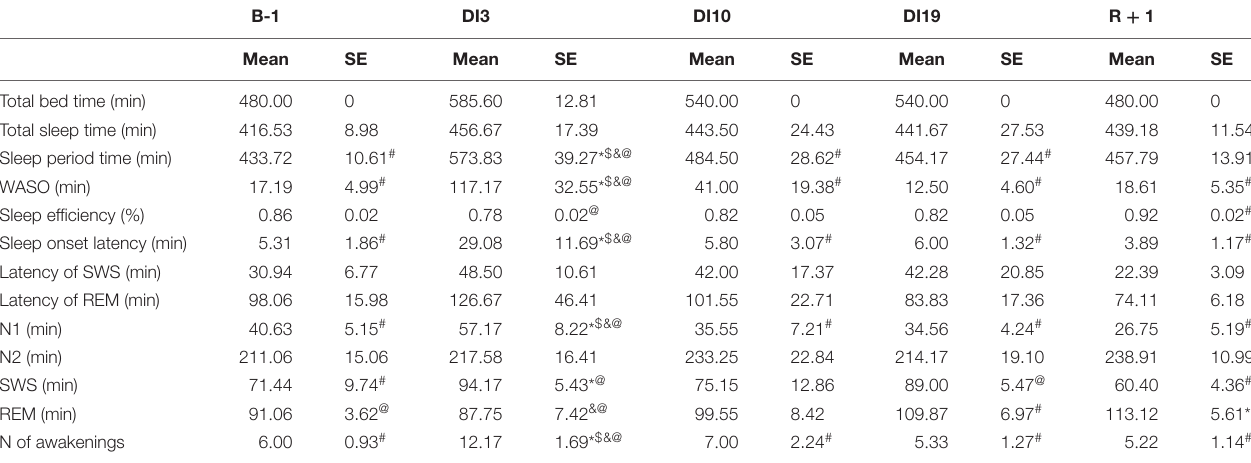
TABLE 1 | Mean values of polysomnographic data in all